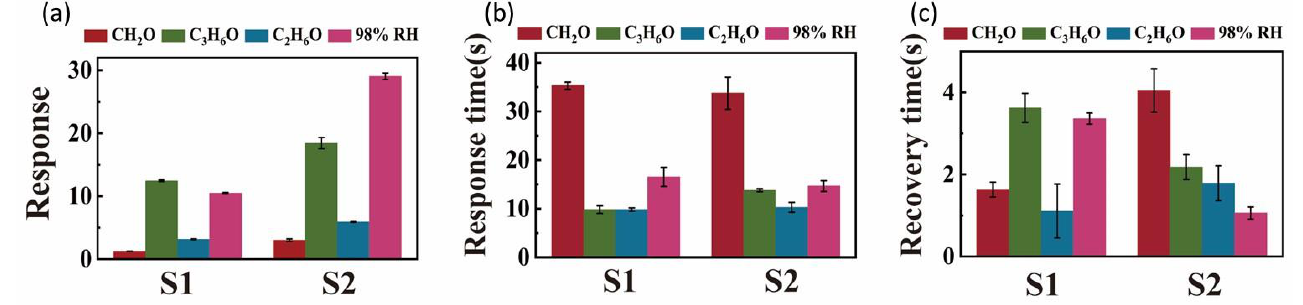
Figure 5. ( a ) Average responses; ( b ) response times; and ( c ) recovery times corresponding to the sensing curves of S1 and S2. sensing curves of S1 and